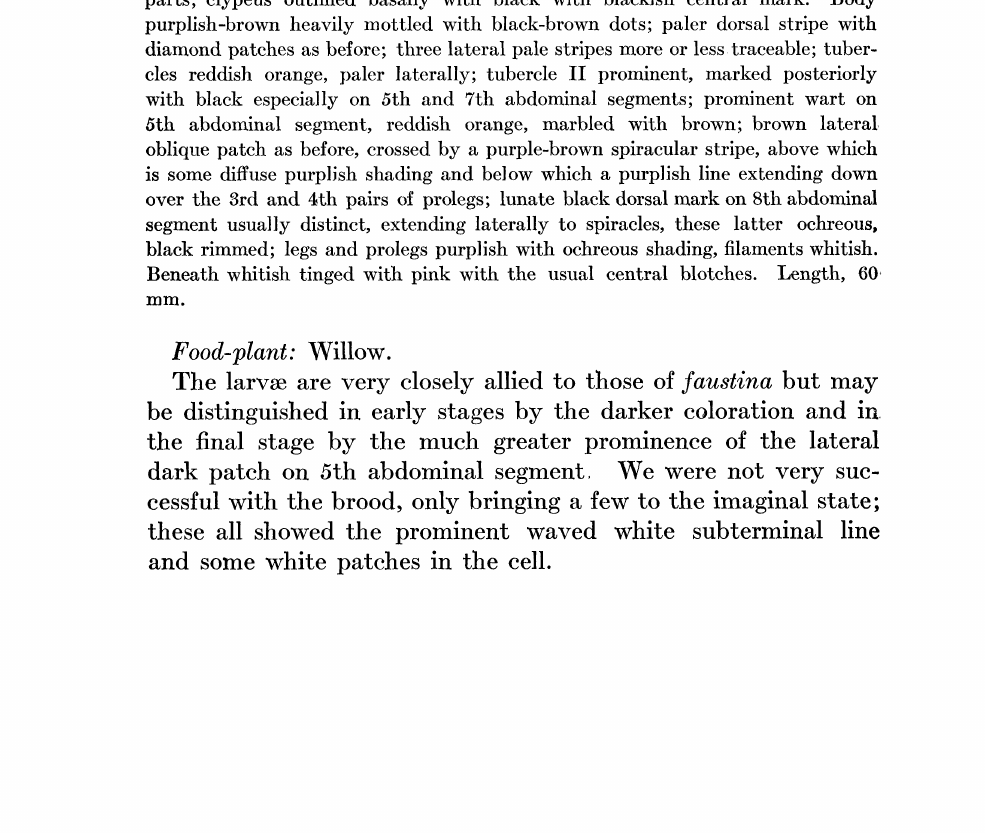
segment almost hidden in the ground-color; tubercles small, black; prolegs pale. Beneath pale with the usual central blotches. Length, 11 ram. Stage III. Head pale, lobes tipped with orange apically, marbled with brown in front and bordered by a deep brown lateral line. Body pale greenish-brown, paler dorsally; dorsal stripe with central dark line; three lateral pale waved stripes bordered with dark brown; tubercles more or less orange; transverse wart of 5th abdominal segment mostly velvety-black, tipped with orange, with strong lateral and posterior black shading extending down over prolegs of 5th and 6th segments; tubercles II of 8th abdominal segment conical with black lunate mark posterior’ to them. Length, 18 mm. Stage IV. Head with the apical orange shading more extended, front of lobes marbled with pale brown with strong lateral black encircling band. Body pale purplish-gray; a rather vague pale dorsal stripe with diamond-shaped enlarge- ments and central dark line; the three lateral stripes indistinct with the border lines broken up into a series of dots; tubercles orange, tubercle II being more prominent than in faustina; a prominent transverse wart on 5th abdominal seg- ment, orange, blackish at base, with black-brown shading extending obliquely laterally as far as the prolegs, much more distinct than in faustina, 8th abdominal segment with conical tubercles dorsally and lunate black-brown mark as before. Length, 6 mm. Stage V. Head purplish in front, marbled with paler, with diffuse orange shading apically and broad black encircling line laterally extending downward to mouth parts; clypeus outlined basally with black with blackish central mark. Body purplish-brown heavily mottled with black-brown dots; paler dorsal stripe with diamond patches as before; three lateral pale stripes more or less, traceable; tuber- cles reddish orange, paler laterally; tubercle II prominent, marked posteriorly with black especially on 5th and 7th abdominal segments; prominent wart on 5th abdominal segment, reddish orange, marbled with brown; brown lateral, oblique patch as before, crossed by a purple-brown spiracular stripe, above which is some diffuse purplish shading and below which a purplish line extending down over the 3rd and 4th pairs of prolegs; lunate black dorsal mark on 8th abdominal segment usually distinct, extending laterally to spiracles, these latter ochreous, black rimmed; legs and prolegs purplish with ochreous shading, filaments whitish. Beneath whitish tinged with pink with the usual central blotches. Length, 60